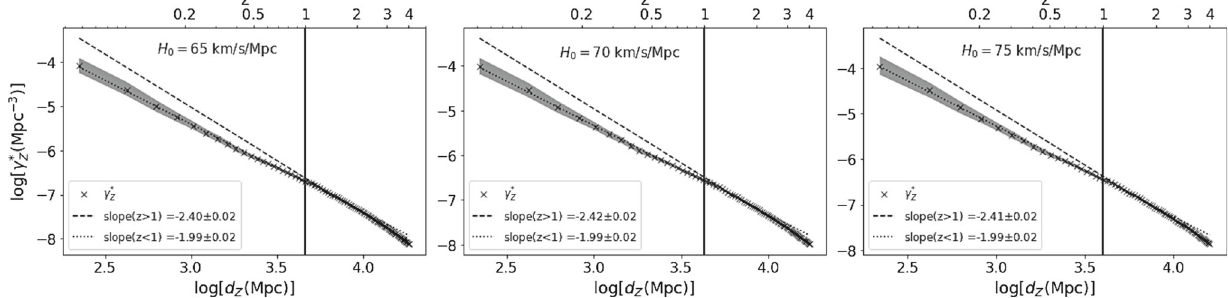
Fig. 8 Log–log graph of γ ∗ vs. d z obtained with the SPLASH galaxy redshift survey dataset in the ranges z < 1 and 1 ≤ z ≤ 4 and respective z distance